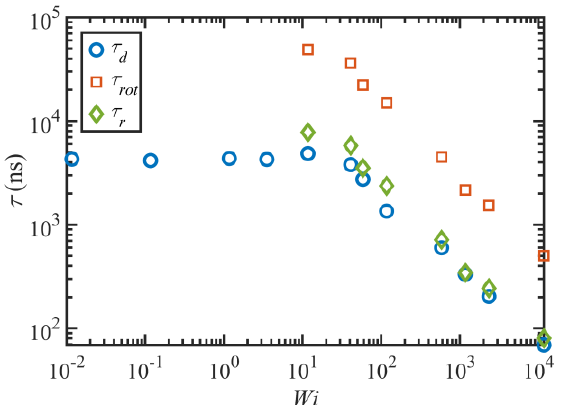
Figure 7. The three characteristic times ( 𝜏 𝑑 , 𝜏 𝑟𝑜𝑡 , and 𝜏 𝑟 ) of the C 1000 H 2002 melt versus 𝑊𝑖 .